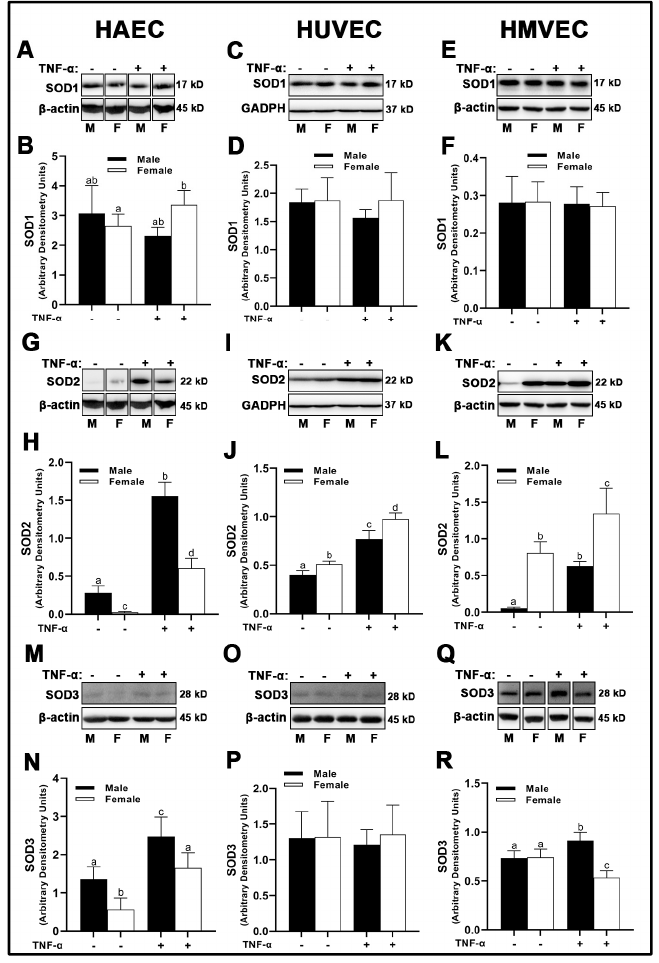
Figure 5. Expression of SOD isoforms in male and female endothelial cells. HAECs, HUVECs and HMVECs were cultured in starvation medium at ~80% confluency for 24 h with or without TNF- α (20 ng/mL). Protein expression of SOD1 ( A – F ), SOD2 ( G – L ) and SOD3 ( M – R ) were determined by Western blot. Quantification was performed using Image Lab (Bio-Rad Laboratories, Inc.). Protein was normalized to respective control bands ( β -actin or GAPDH). Data are expressed as mean ± SD